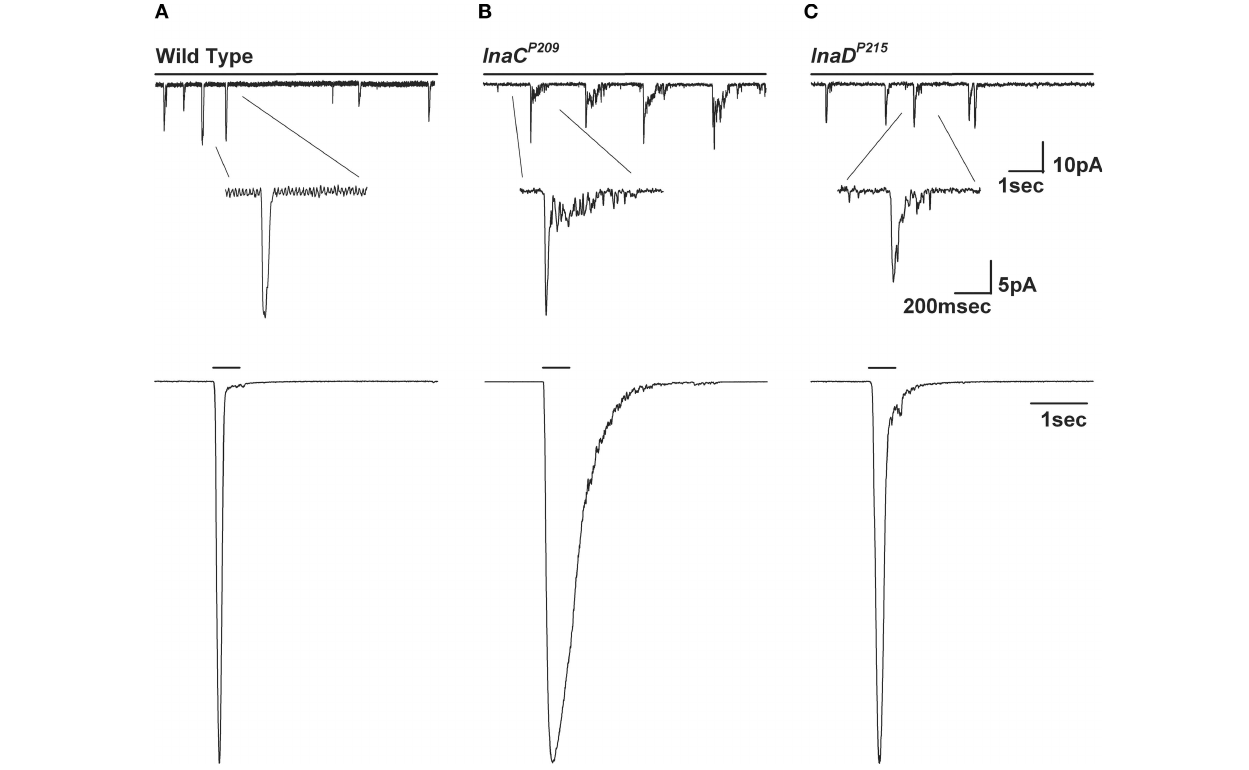
(A–C) Lower panels: Whole-cell voltage clamp recordings of normalized responses to a 500-ms light pulse of the above mutants. A slow termination of macroscopic response is observed in inaC P209 null mutant and in the inaD P215 mutant in which the binding of INAD to TRP is disrupted (Chevesich et al., 1997; Shieh and Zhu,